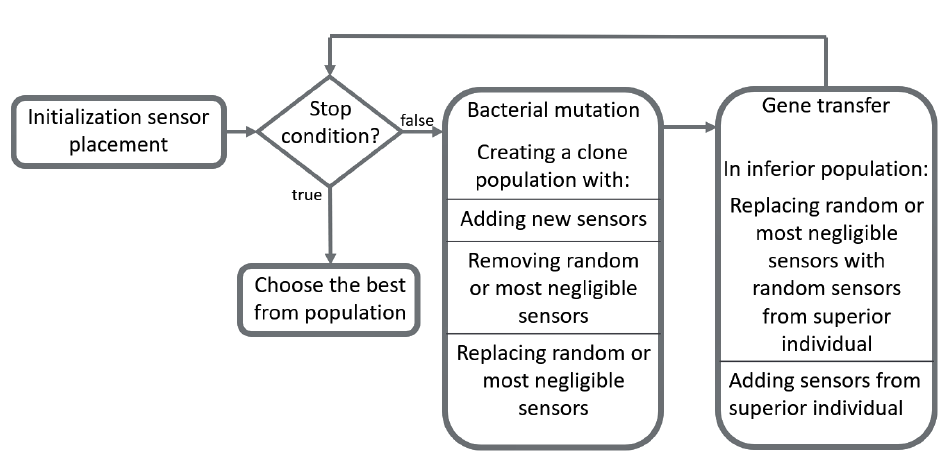
Figure 7. Bacterial Evolutionary Algorithm used for sensor placement.